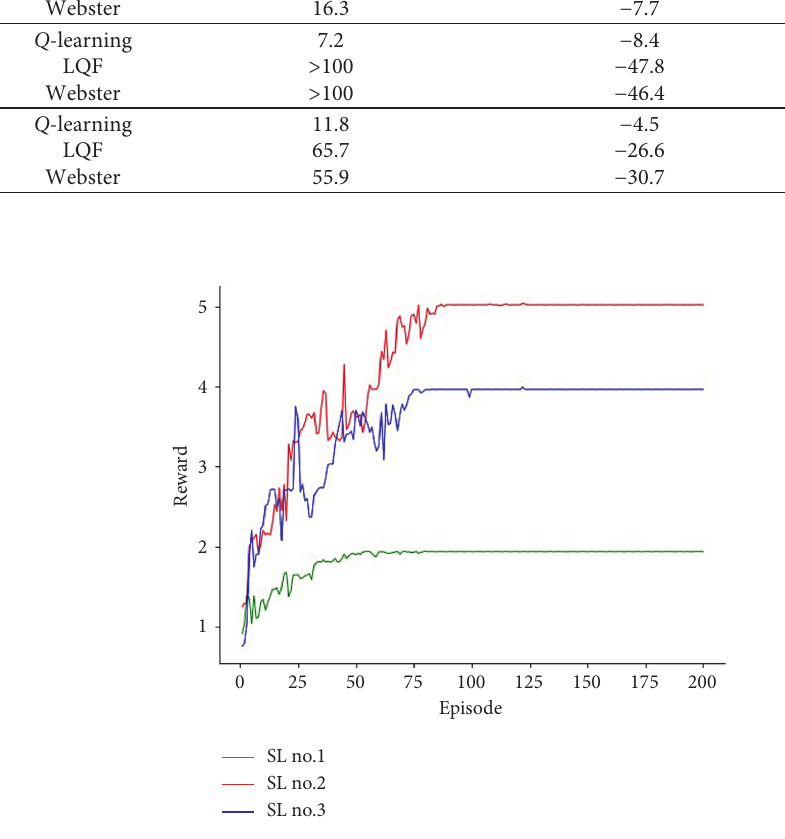
Figure 10: Episode rewards of our model in training process in single-intersection